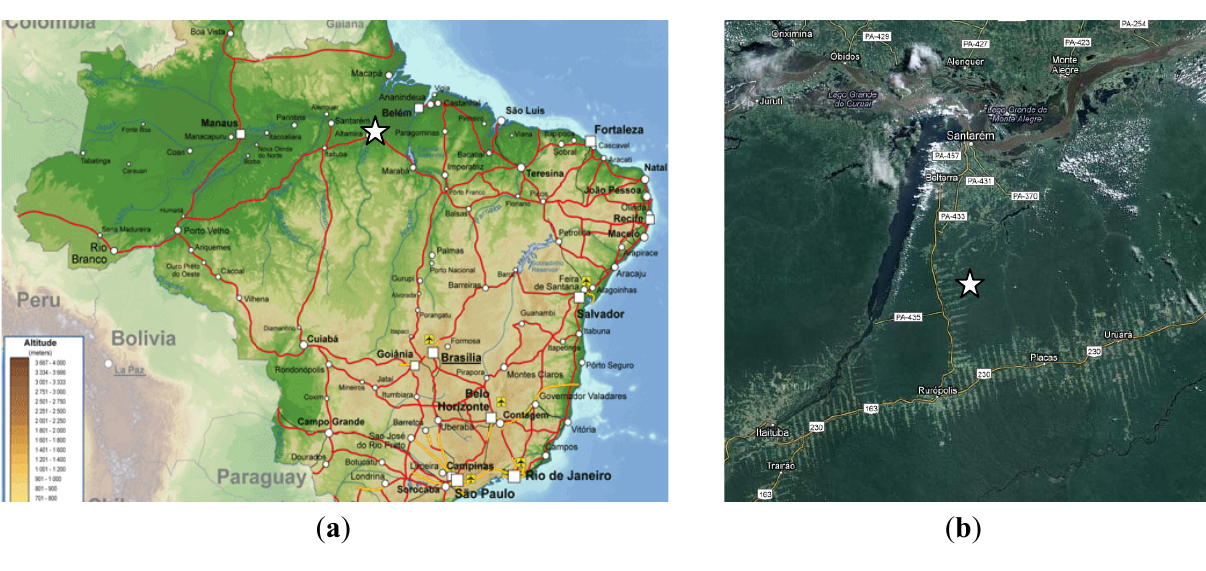
Figure 1. Location of the study sites and the permanent sample plots; ( a ) Map of Brazil showing the location of the agrarian settlement Mojú (white star); ( b ) detail of the region